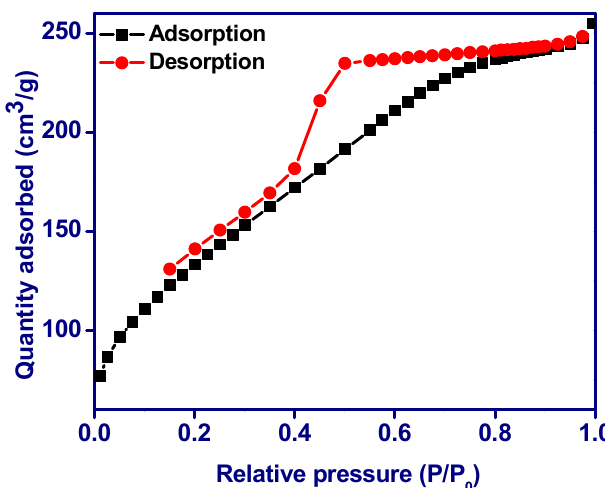
Figure 5. N 2 adsorption–desorption isotherm of NDG.